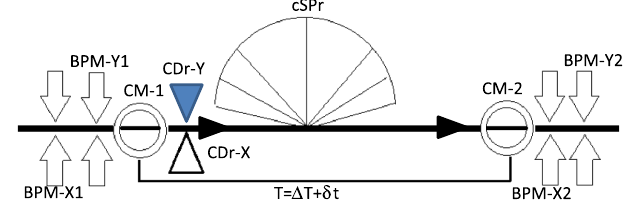
FIG. 12. A schematic of the conceptual design of the cSPr suite of the monitors which will enable 3D single shot, noninvasive, bunch image reconstruction. The suite includes: BPM-(X,Y) monitors, detuned by δ t bunch charge monitors (CM-1,2) and coherent diffraction radiation (CDr-X,Y) monitors to measure the bunch transverse